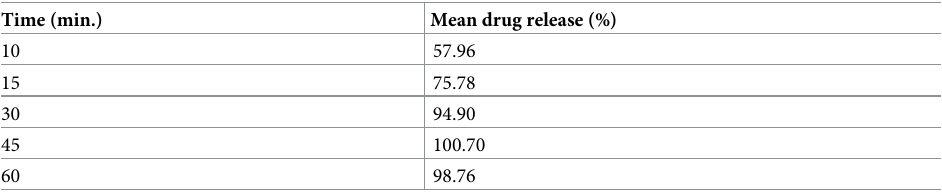
Table 7. Data for the in-vitro dissolution test for Tykerb 1 tablets. Time